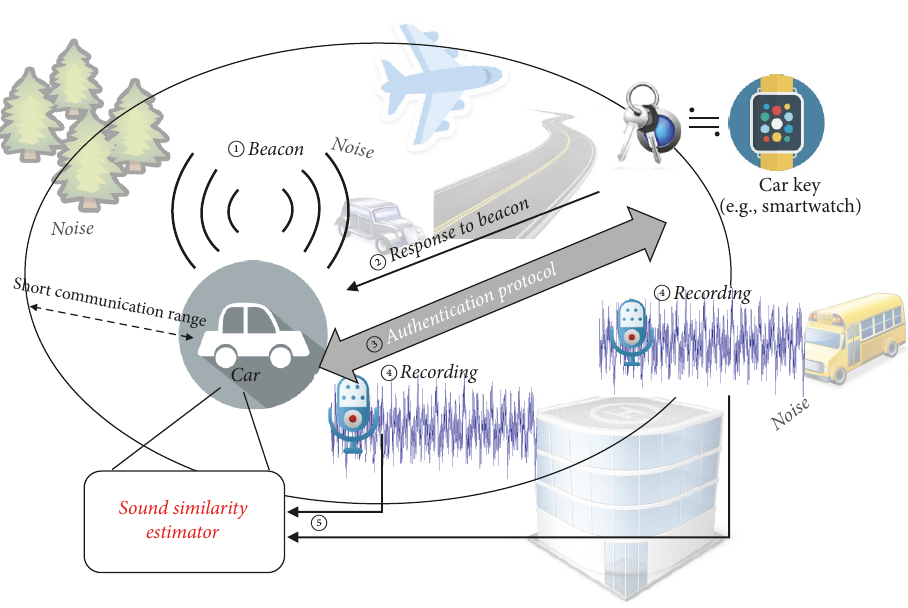
Figure 2: System